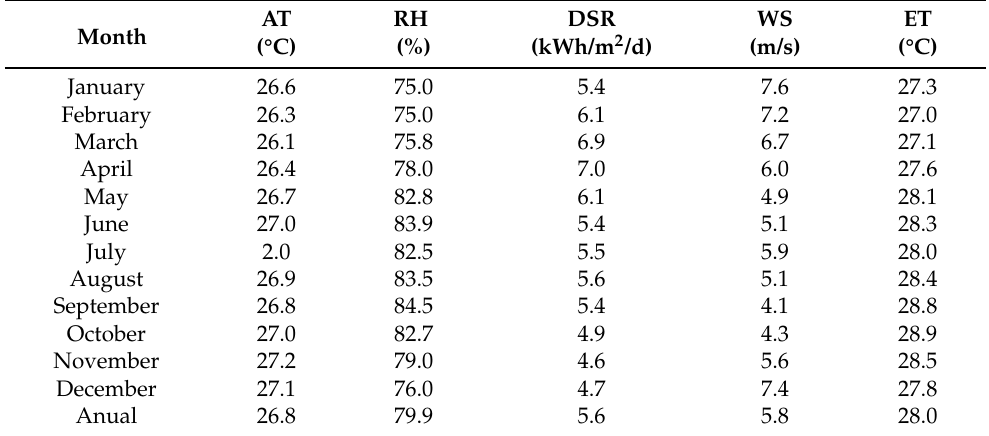
Table 1. Climatological data of San Andrés Island, average of the last ten years. Source NASA. AT RH DSR Month (°C)